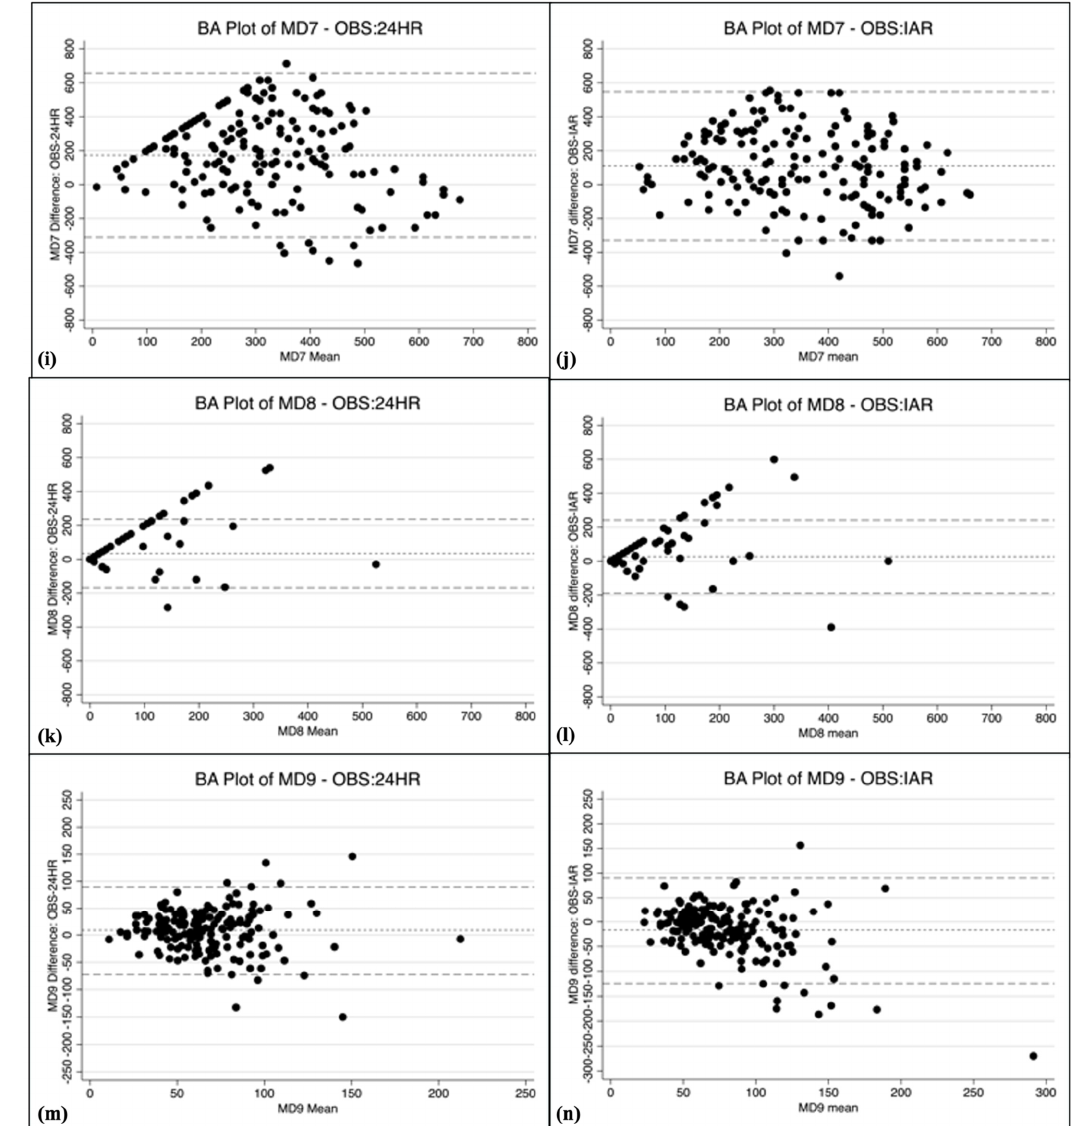
Figure 2. Bland–Altman (BA) plots of time allocation difference versus the mean of observation (OBS) and 24 h recall (24HR) or image assisted recall (IAR). ( a ) BA plot for employment and related activities (MD1), OBS and 24HR, ( b ) BA plot for employment and related activities (MD1), OBS and IAR, ( c ) BA plot for production of goods for own final use (MD2), OBS and 24HR and ( d ) BA plot for production of goods for own final use (MD2), OBS and IAR. ( e ) BA plot for unpaid domestic services for household and family members (MD3), OBS and 24HR, ( f ) BA plot for unpaid domestic services for household and family members (MD3), OBS and IAR, ( g ) BA plot for unpaid caregiving services for household and family members (MD4), OBS and 24HR, and ( h ) BA plot for unpaid caregiving services for household and family members (MD4), OBS and IAR, ( i ) BA plot for socializing and communication, community participation, and religious practice (MD7), OBS and 24HR, ( j ) BA plot for socializing and communication, community participation, and religious practice (MD7), OBS and IAR, ( k ) BA plot for culture, leisure, mass media, and sports practices (MD8), OBS and 24HR, and ( l ) BA plot for culture, leisure, mass media, and sports practices (MD8), OBS and IAR, ( m ) BA plot for self-care and maintenance (MD9), OBS and 24HR, and ( n ) BA plot for self-care and maintenance (MD9), OBS and AR. The dotted line is the mean difference (bias), the long-dashed lines are +/ − 2SD limits of agreement (LOA). A bias > 0 indicates that 24HR or IAR underestimates time